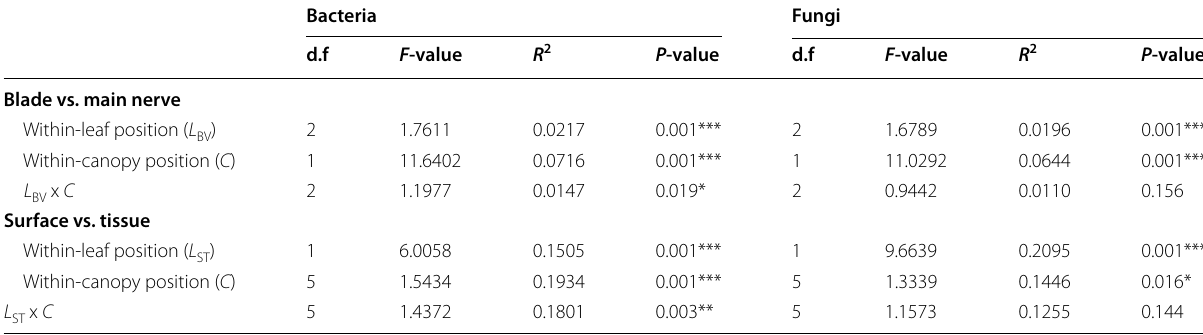
Table 4 Effects of within-canopy and within-leaf positions on the composition of phyllosphere microbial communities of European beech ( Fagus sylvatica ), tested using permutational multivariate analyses of variance (PERMANOVA). Compositional dissimilarities among samples were estimated using a binary version of the Jaccard index. The effects of within-canopy position ( C ), within-leaf position ( L : blade edge, blade central part or main nerve), and their interaction were tested using sample Set#2 (Fig. 1C). BV The effects of within-canopy position ( C ), within-leaf position ( L : surface vs. tissue), and their interaction were tested using sample ST Set#3 (Fig. 1C). Permutations were constrained by sampling date ( D ) and tree identity ( T )